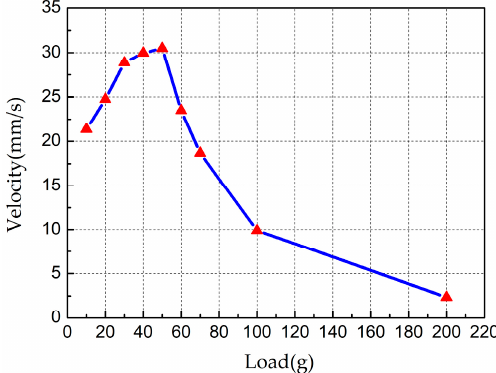
Figure 9. Plot of the output velocity versus the different input voltages.